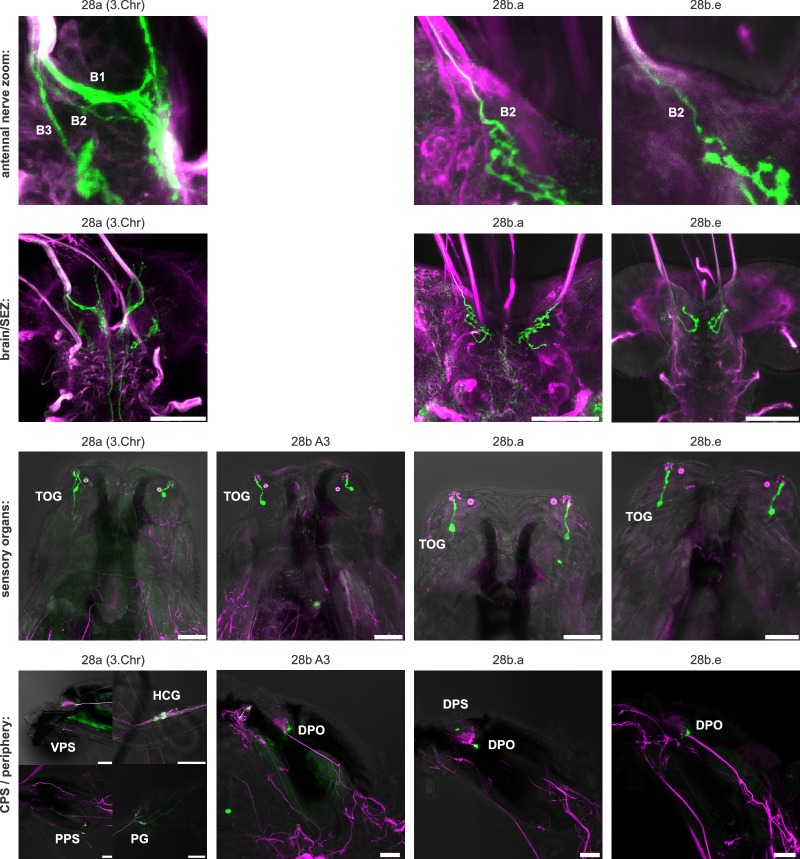
Gustatory receptor expression.Top row scale and all scale bars = 50 µm.